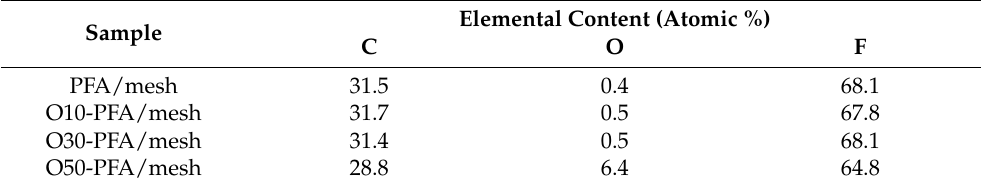
Table 1. The atomic percentage of carbon and oxygen on the surface with the variation in the oxygen gas fraction in the oxyfluorination